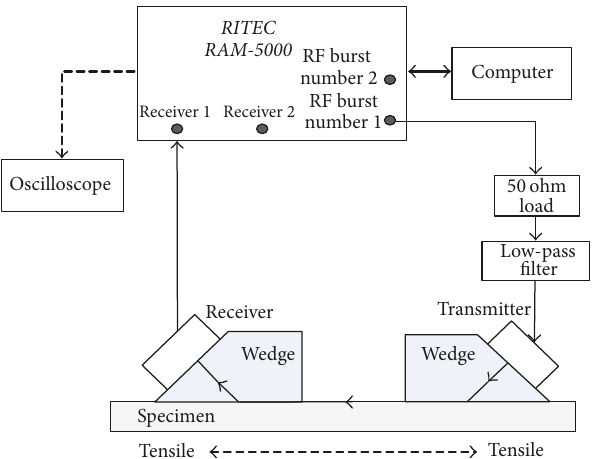
Figure 3: Experimental setup for the ultrasonic measurement based on L CR